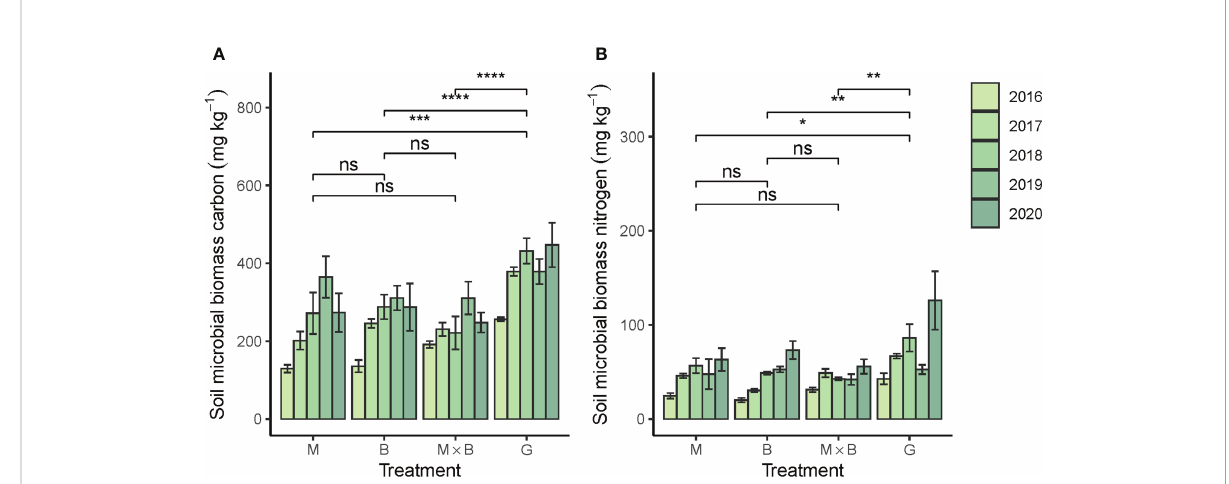
FIGURE 5 Year-to-year variations in soil microbial biomass carbon (A) and nitrogen (B) contents under the alfalfa (M) and smooth bromegrass (B) monocultures and the M×B mixture in comparison with a natural grassland (G) during the experimental period from 2016 to 2020. Belowground biomass was